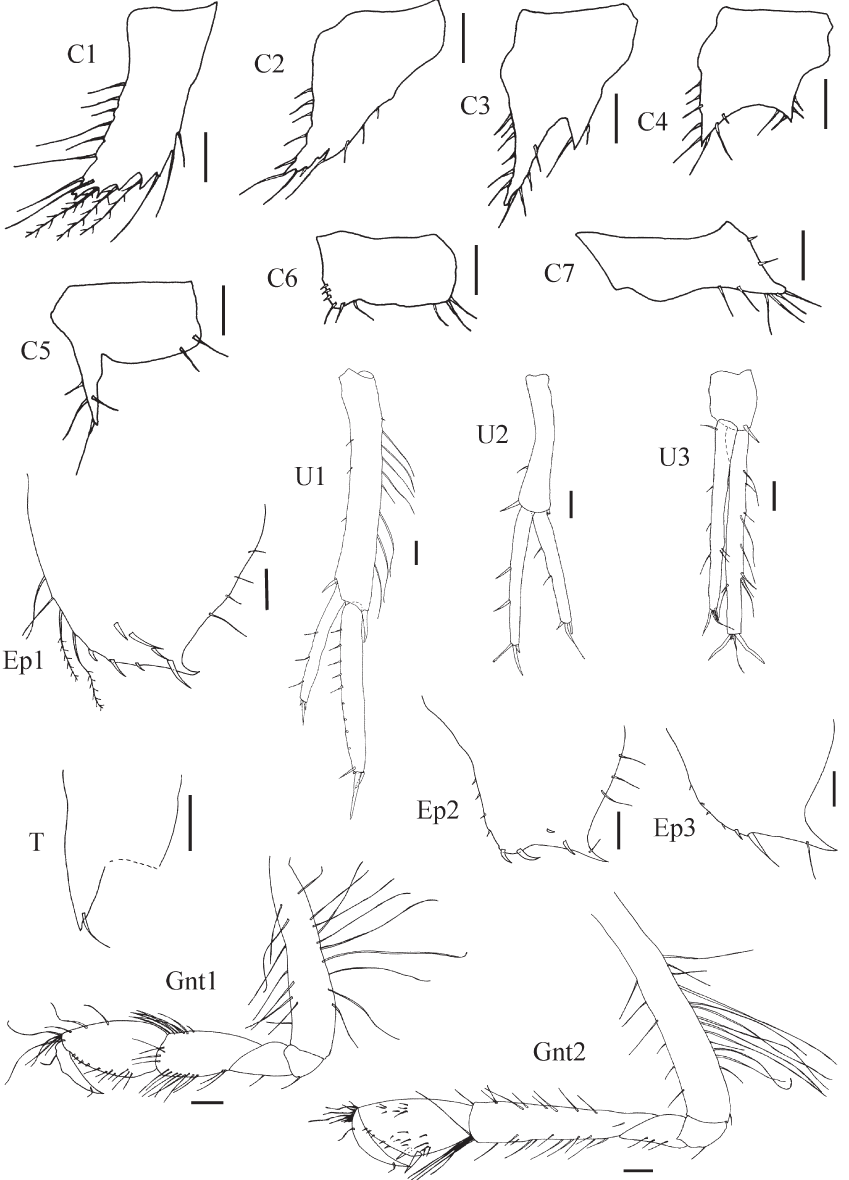
Fig . 3. – Lepechinella campensis n. sp., holotype, sex unknown, 5.7 mm, MnrJ17384, oceanprof i #45, 22°10’54.4”S to 39°52’19.4”w. Scale bars = 0.1